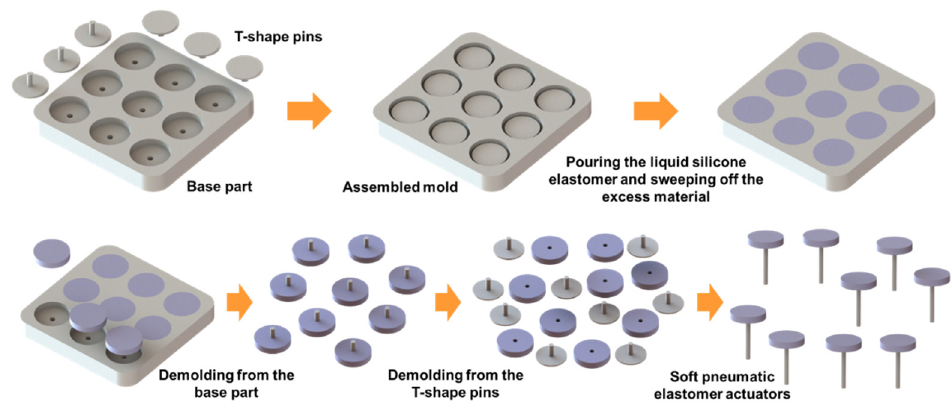
Figure 7. The fabrication process of the soft pneumatic elastomer actuators.